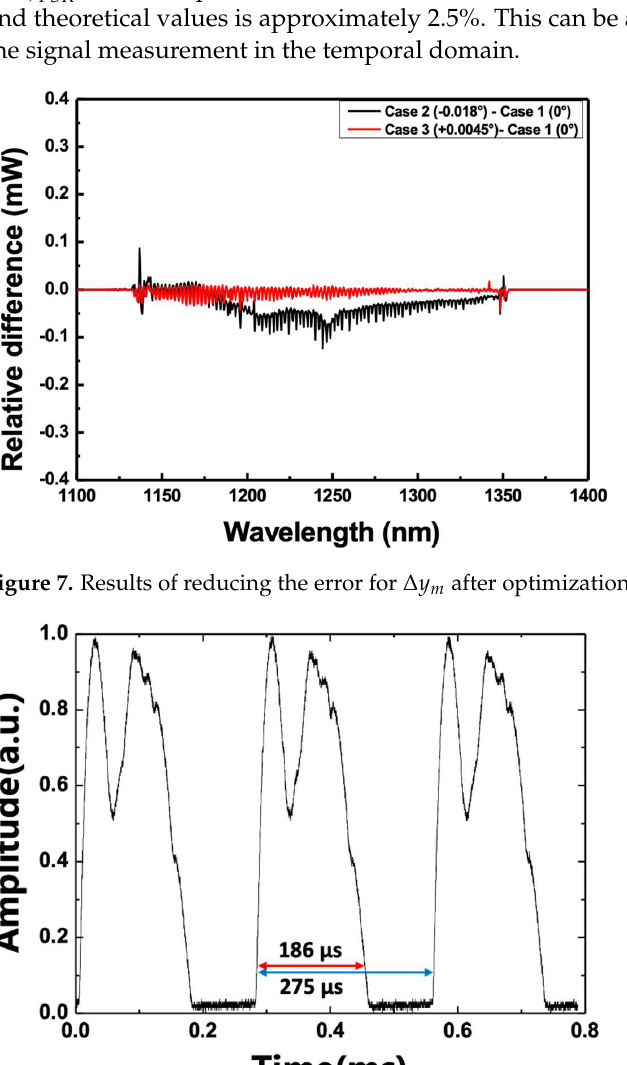
Figure 8. Temporal output from the wideband WSL.